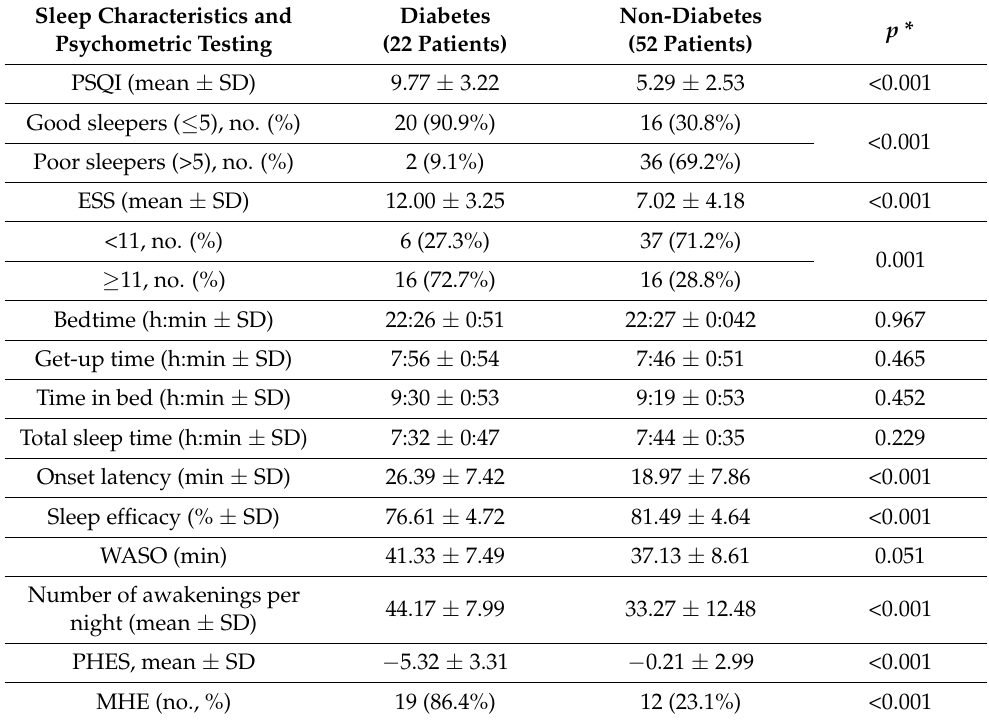
Table 7. Sleep evaluation and psychometric testing of patients with diabetes in comparison with those without diabetes.